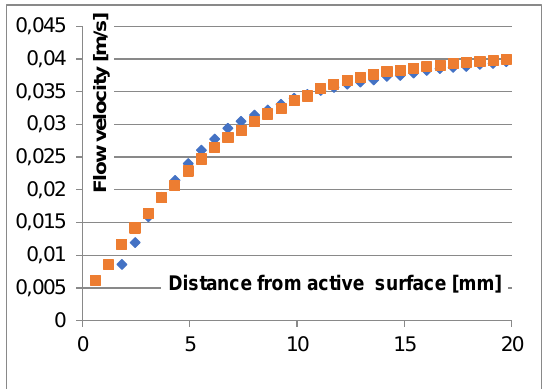
Fig. 6 Re=2000; Dependence of Velocity on the distance from active surface, which is on the position 0